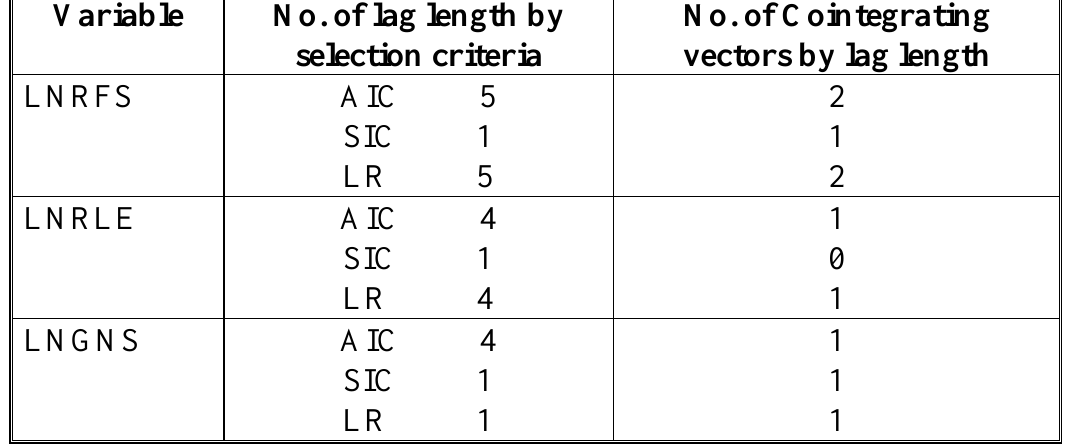
Johansen cointegration test Variable No. of lag length by selection criteria LNRFS AIC 5 SIC